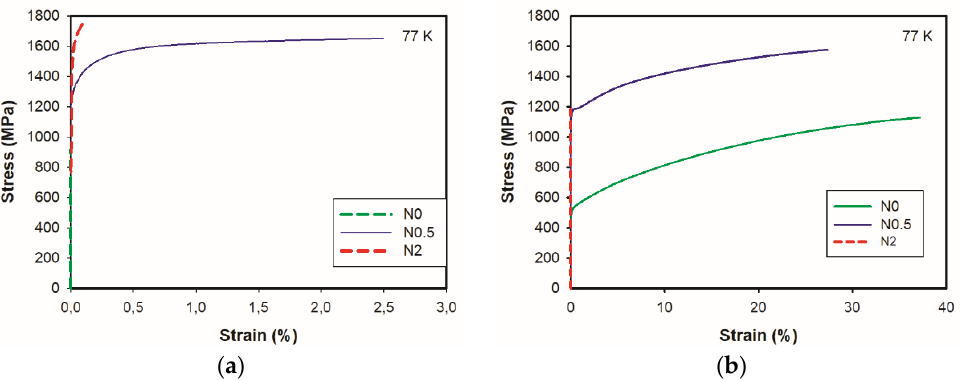
Figure 8. Stress–strain curves of the Fe 40-x Mn 40 Cr 10 Co 10 N x alloys after cold rolling and annealing at 700 °C ( a ) and 900 °C ( b ) obtained during tensile testing at cryogenic temperature (77 K). Table 5. The cryogenic mechanical properties of the Fe 40-x Mn 40 Cr 10 Co 10 N x alloys after annealing.